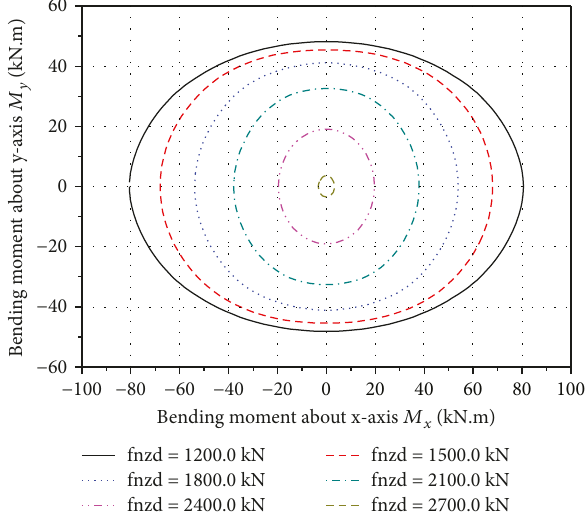
− M Figure 8: M x y interaction curves of the composite column tested by Karimi et al. [15] under di ff erent axial load